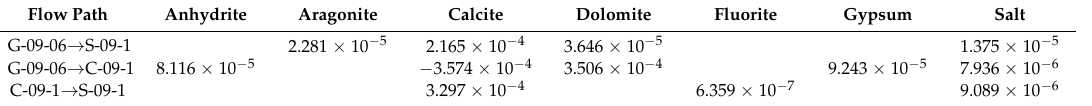
Table 2. Calculated results of mass transfer along different flow paths in the study